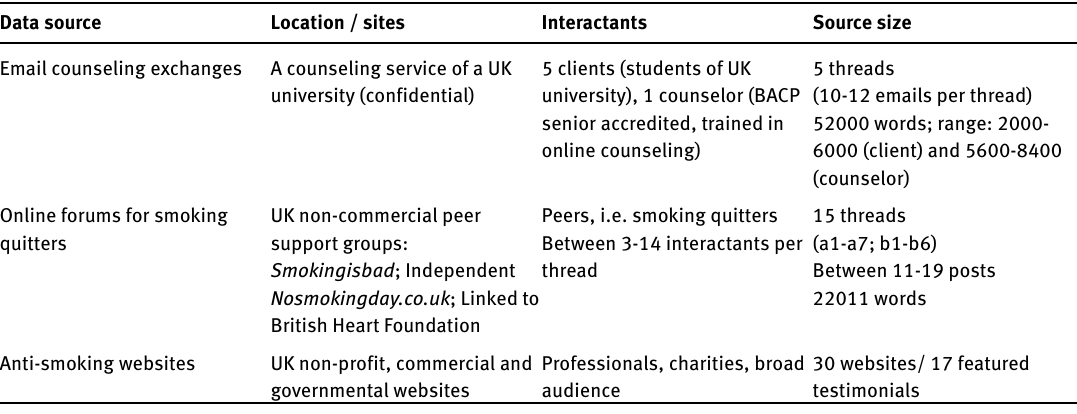
Table 1: Overview of